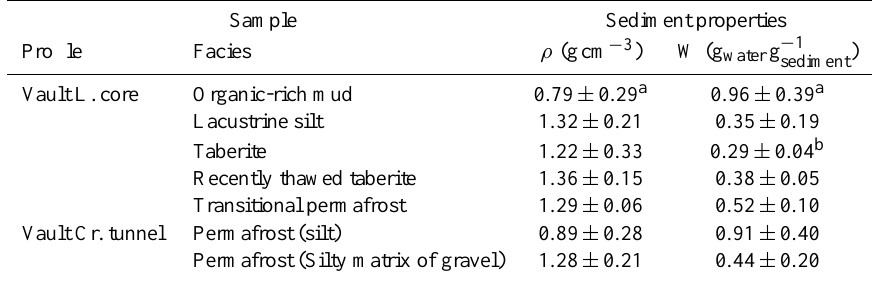
Table 3. Summary of dry bulk density ( ρ ) and gravimetric water content (W) data from the Vault Lake core and the Vault Creek permafrost tunnel. Data are presented as mean ± SD.